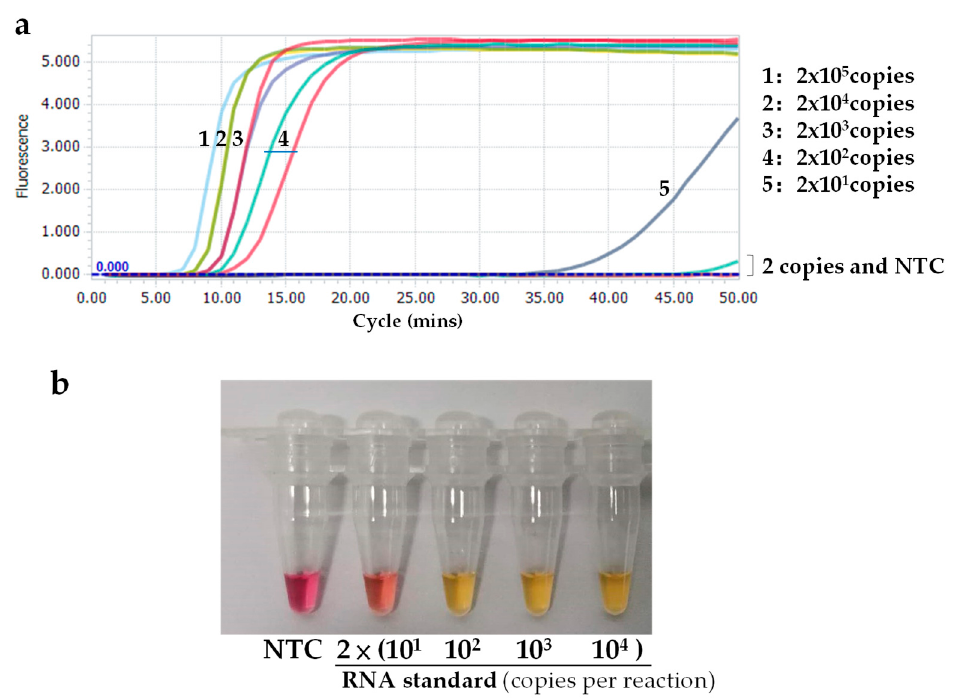
Figure 3. Sensitivity of the novel SARS-CoV-2 RT-LAMP assay. ( a ) Real-time monitoring with SYTO9; ( b ) Visual detection with cresol red. NTC: non-template control. Table 2. Limit of detection (LOD) of the novel SARS-CoV-2 RT-LAMP assay.